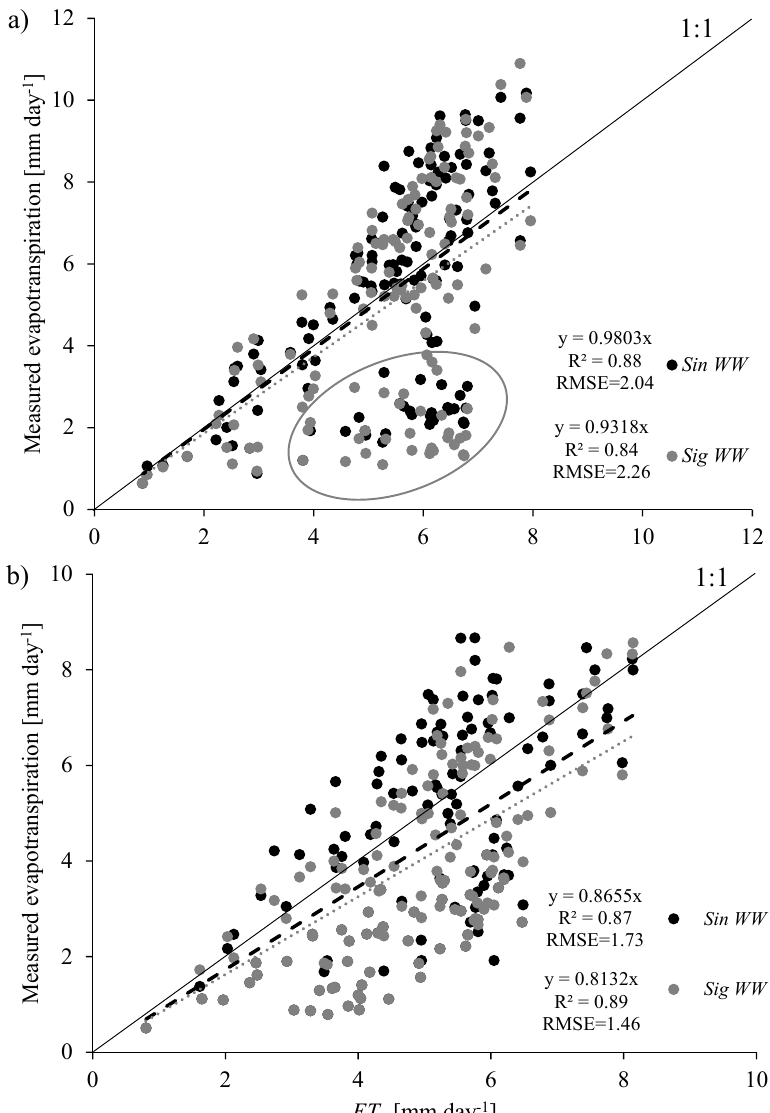
Figure 10. ( a , b ) Relationship between daily measured evapotranspiration rate ( ETR ) in Sinara ( Sin WW ) and Sigalia ( Sig WW ) and daily reference evapotranspiration ( ET 0 ) over the 2017 ( a ) and 2018 ( b ) growing seasons. ET 0 was derived from the FAO-56 equation (Penman–